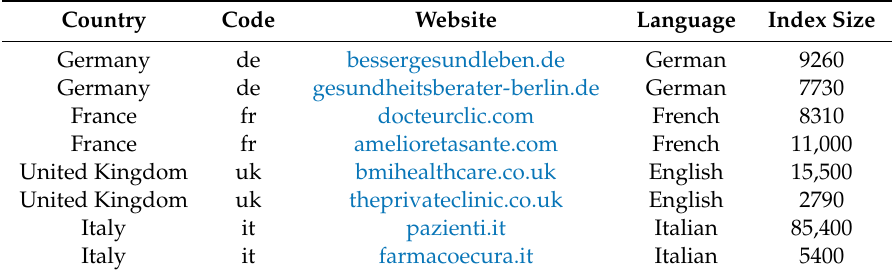
Table 1. List of collected websites across 10 European countries for Google medical